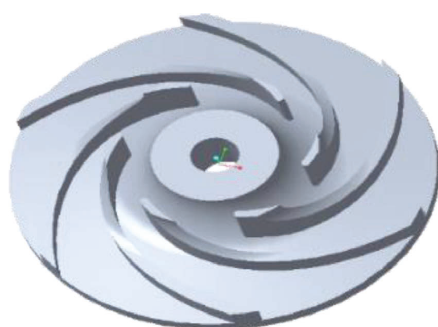
Figure 1: Three-dimensional view of the impeller.